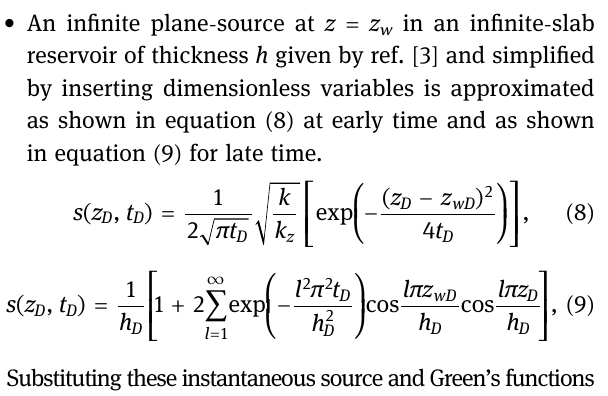
(cid:129) An in fi nite plane - source at z = z